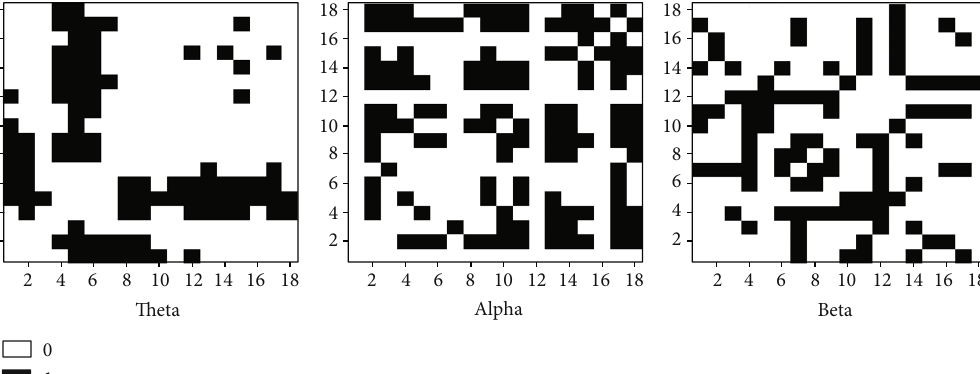
Figure 4: Coherence statistical matrix.